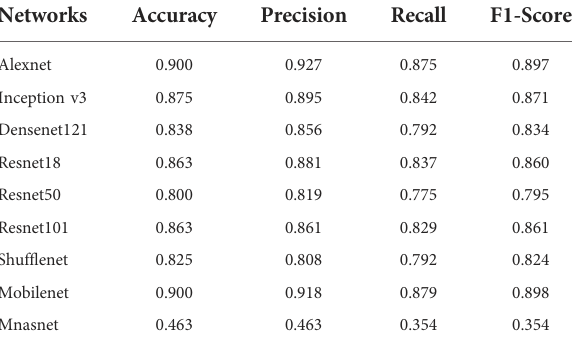
TABLE 2 The performance of convolutional neural networks for assessing the severity of microtia.